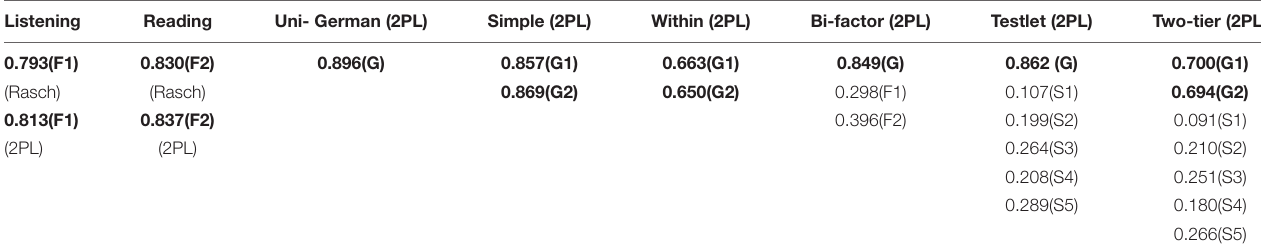
FIGURE 9 | Pearson correlations between subtest scores and German test scores (test scores estimated with the MAP method) and correlations between general factor scores and scores estimated with specific factors were indicated. Symbols used in the matrix were indicated as follows: G, general factor; S, specific factor; R, Rasch model; 2, two-parameter model. TABLE 1 | The empirical internal reliabilities of scores which estimated on general and specific